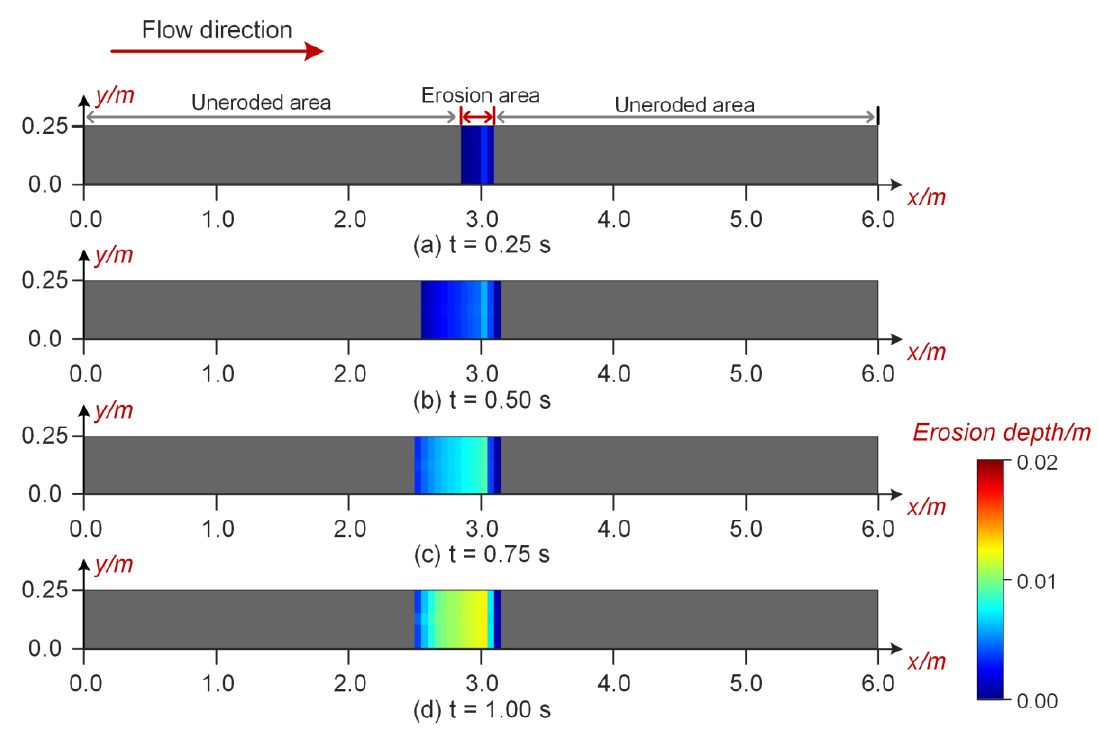
Figure 10. Erosion depth distribution at different time.